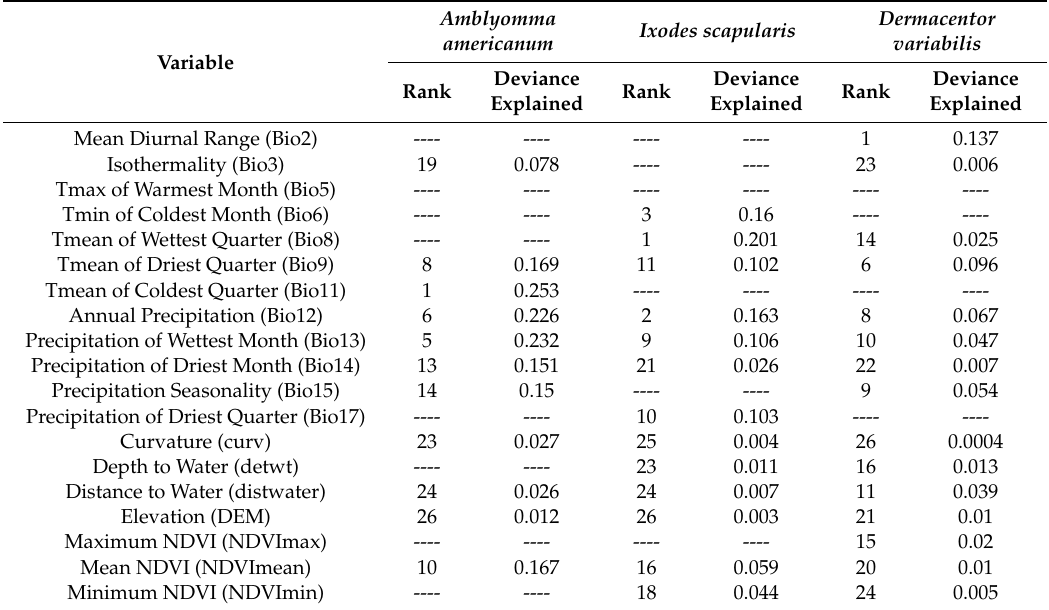
Table 2. Deviance explained by considered variables and rank via univariate generalized additive models (GAM) for each species. NDVI is the Normalized Di ff erence Vegetation Index, a proxy for vegetation